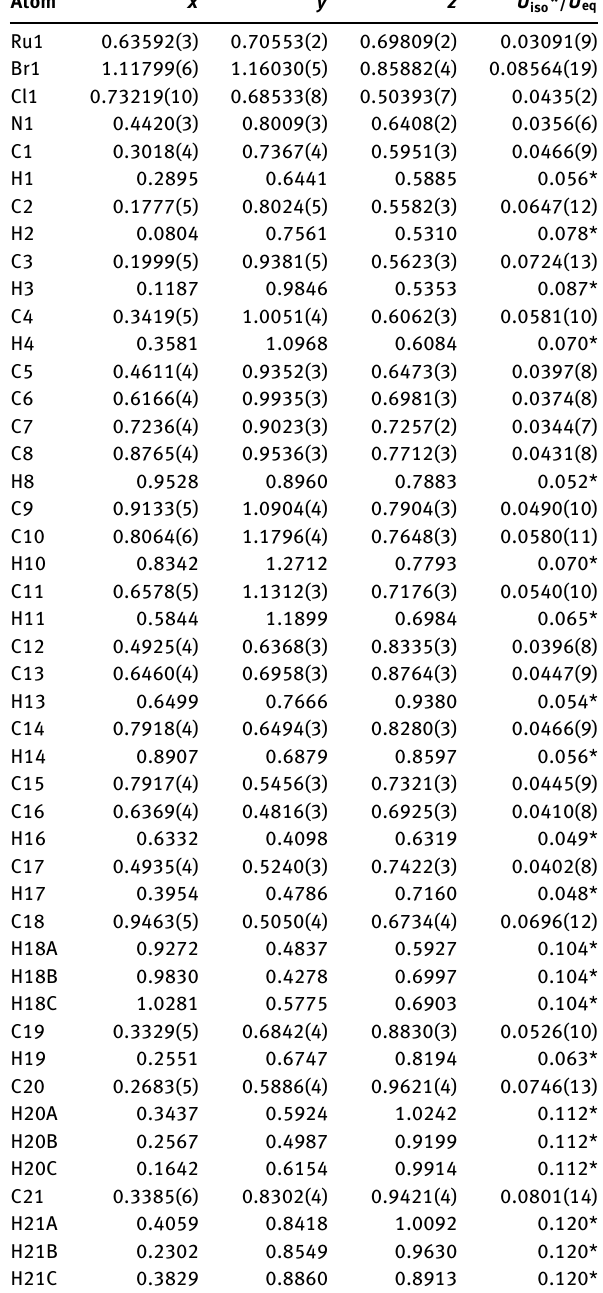
Table 2: Fractional atomic coordinates and isotropic or equivalent isotropic displacement parameters (Å 2